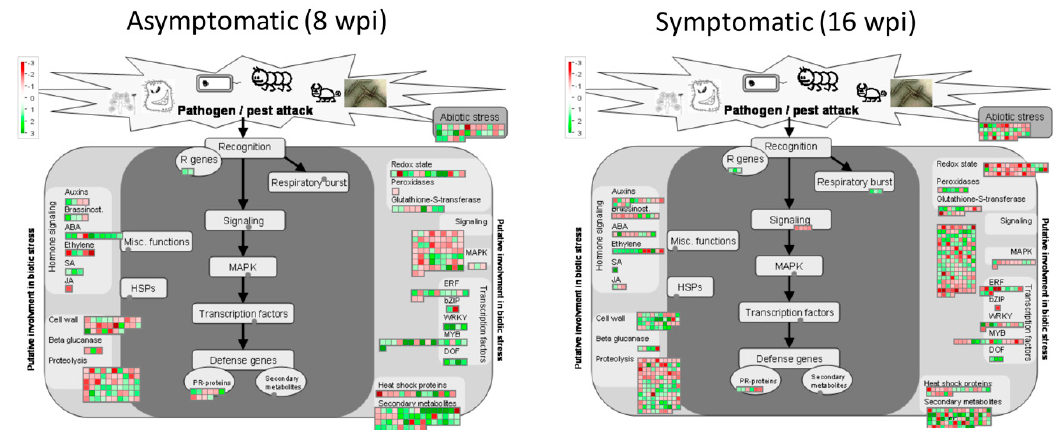
Figure 10. Regulation of stress-related gene pathways by CLas infection in Mexican lime ( Citrus aurantifolia ). Genes that were significantly upregulated following CLas infection are displayed in green, and downregulated genes are displayed in